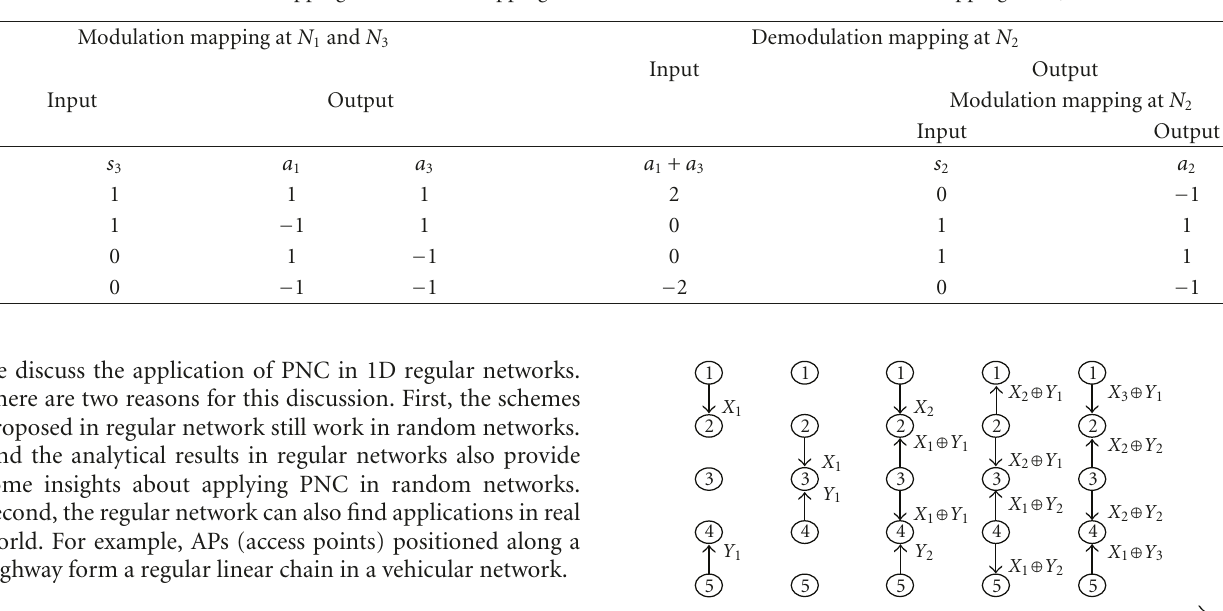
Table 1: PNC Mapping: modulation mapping at N 1 , N 2 ; demodulation and modulation mappings at N 3 .